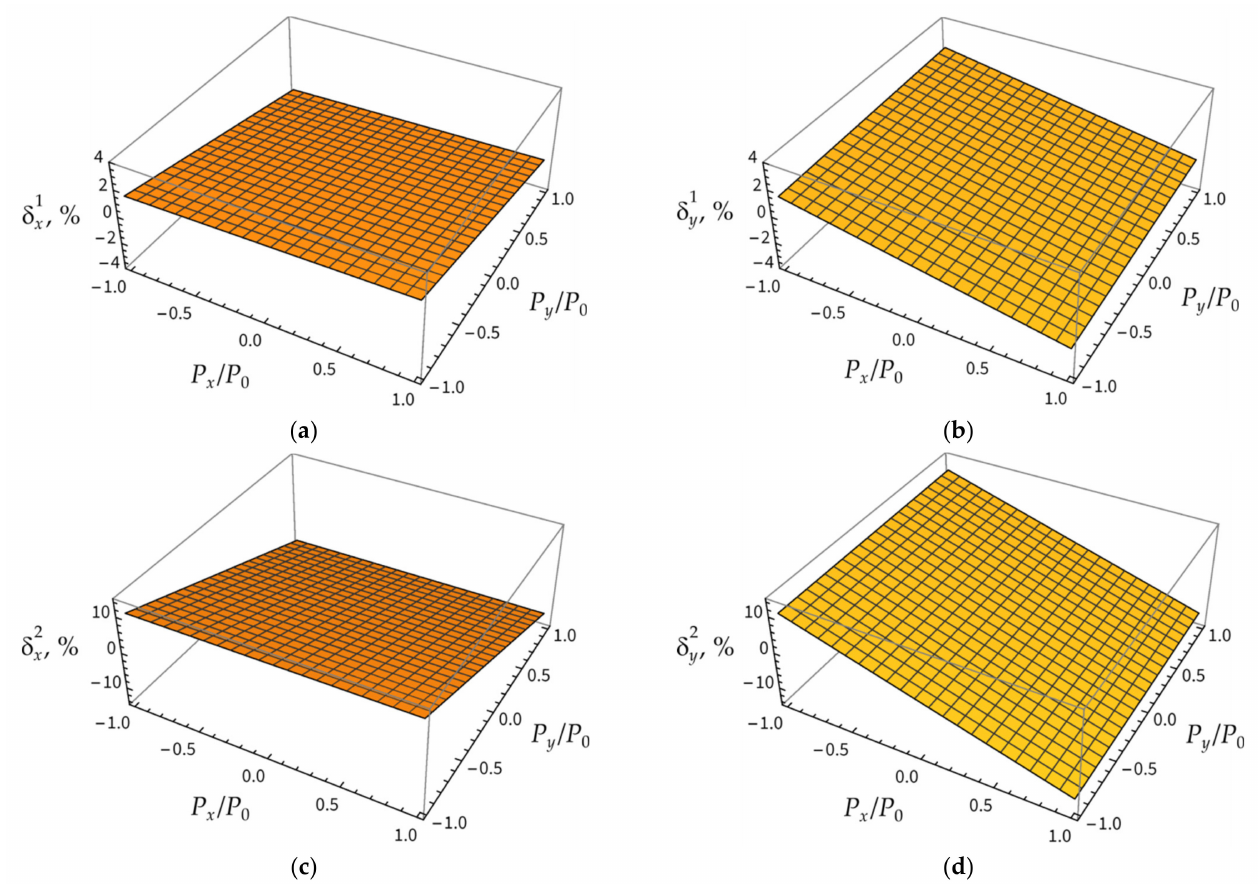
Figure 12. The values of errors δ 1 x ( a ), δ 1 y ( b ), δ 2 x ( c ), δ 2 y ( d ) at different loads P x / P 0 and P y / P 0